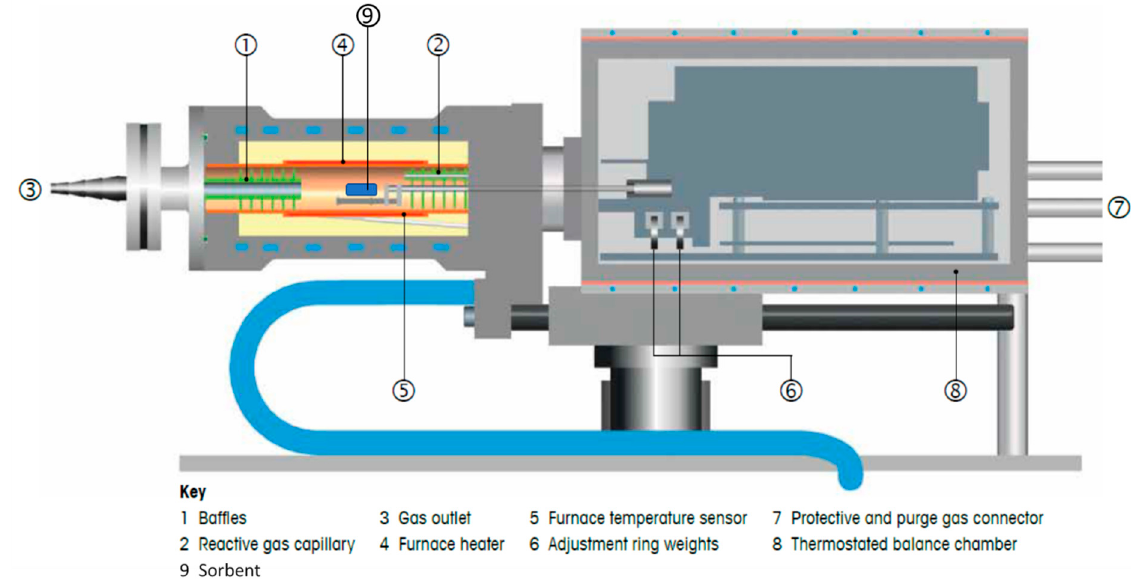
Figure A7. Schematic of TGA2 thermogravimetric balance used for the CO 2 capture tests. [modified from: https://www.mt.com/dam/Analytical/ThermalAnalysi/TA-PDF/TGA2_Broch_EN_30247078_V04.15_Original_38299.pdf] (accessed on 9 November 2022).